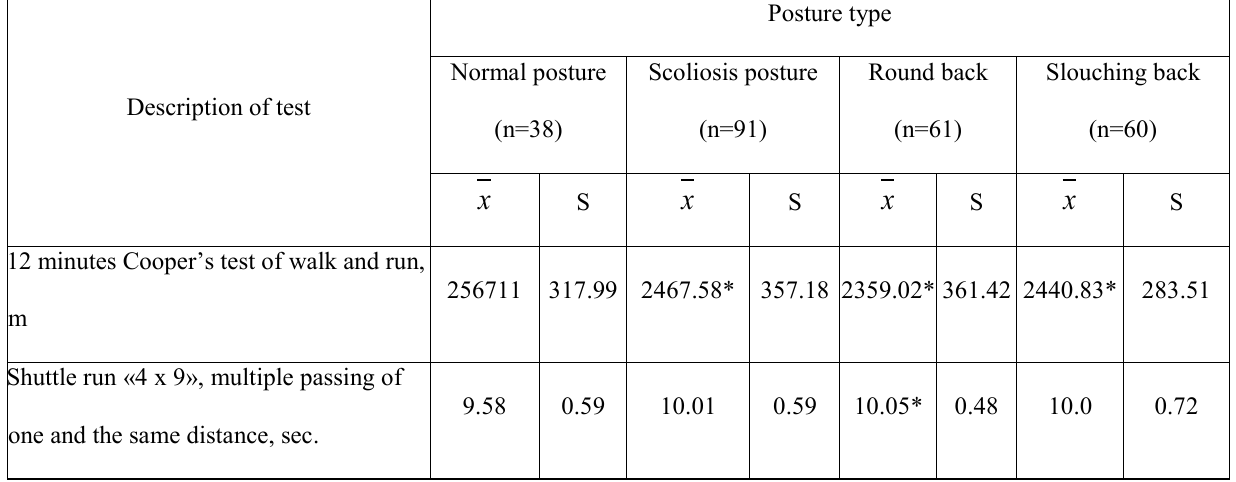
Physical fitness indicators of students with different posture abnormalities